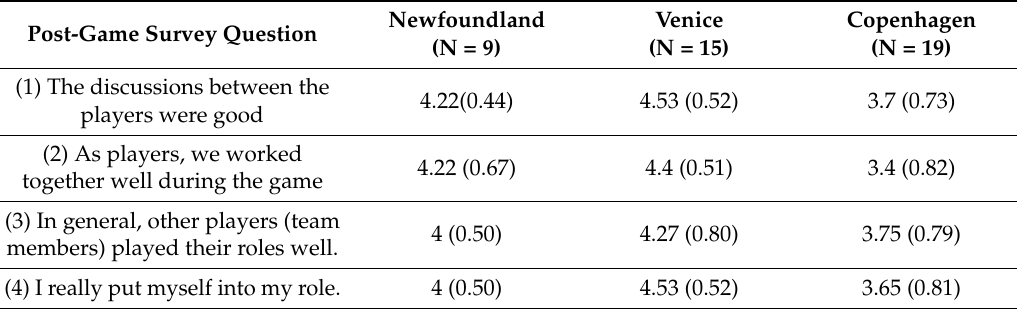
Table 6. Average question score with standard deviation in parenthesis for post-game survey questions that look at